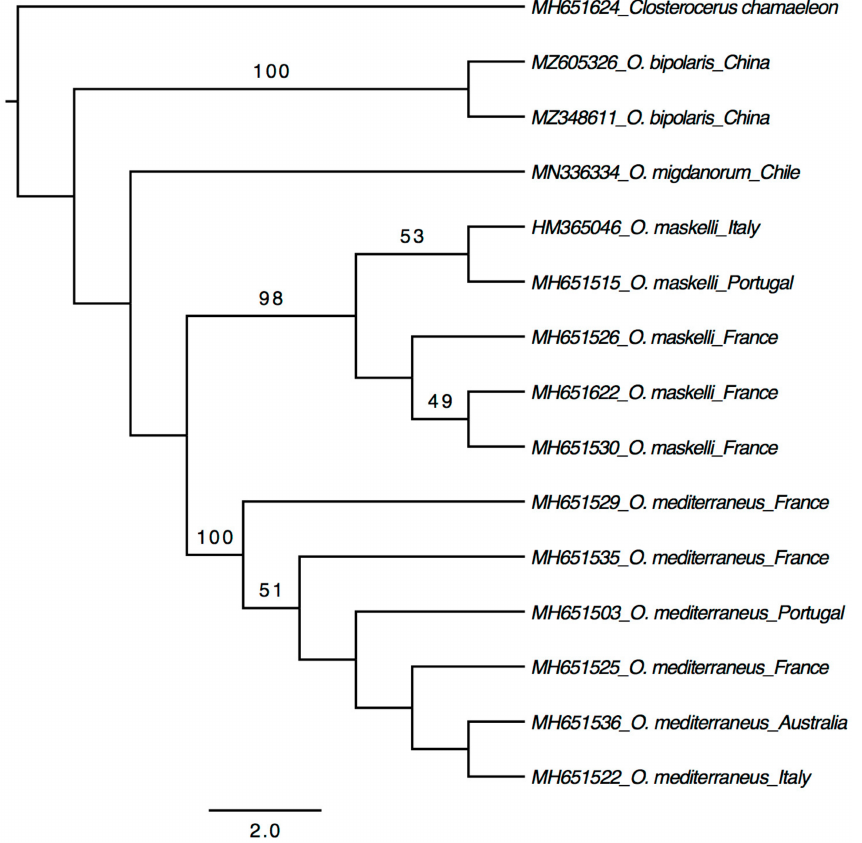
Figure 4. Maximum likelihood tree based on COI , only values >50 for bootstrap are